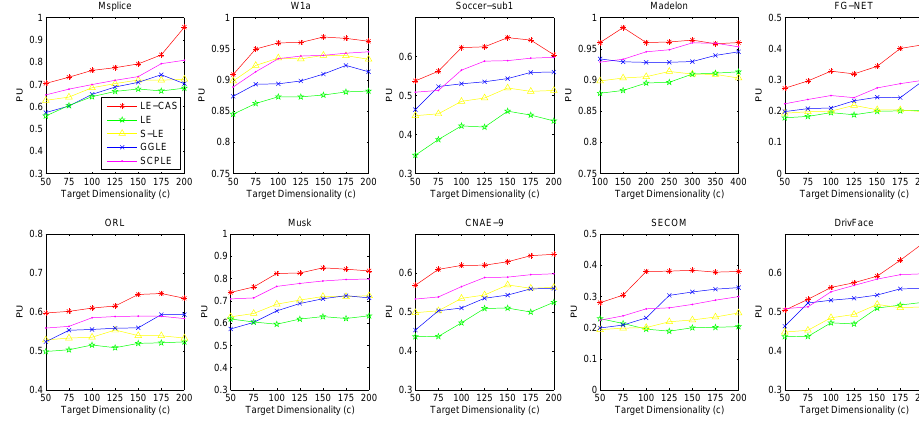
Figure 4. Results of PU on ten datasets (Msplice, W1a, Soccer-sub1, Medelon, FG-NET, ORL, Musk, CNAE-9, SECOM, DrivFace) under different target dimensionalities ( c